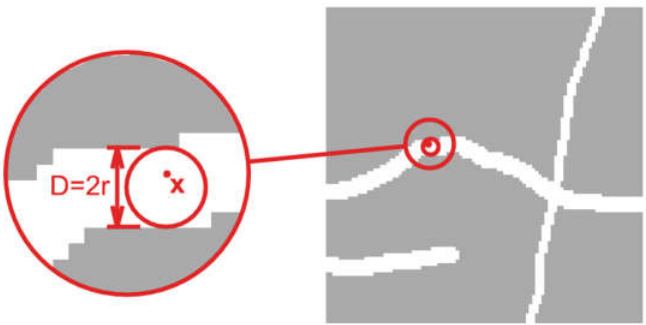
Figure 14. Element width in point x , as maximum diameter of inscribed circle Figure 14 . Element width in point x , as maximum diameter of inscribed circle [21].